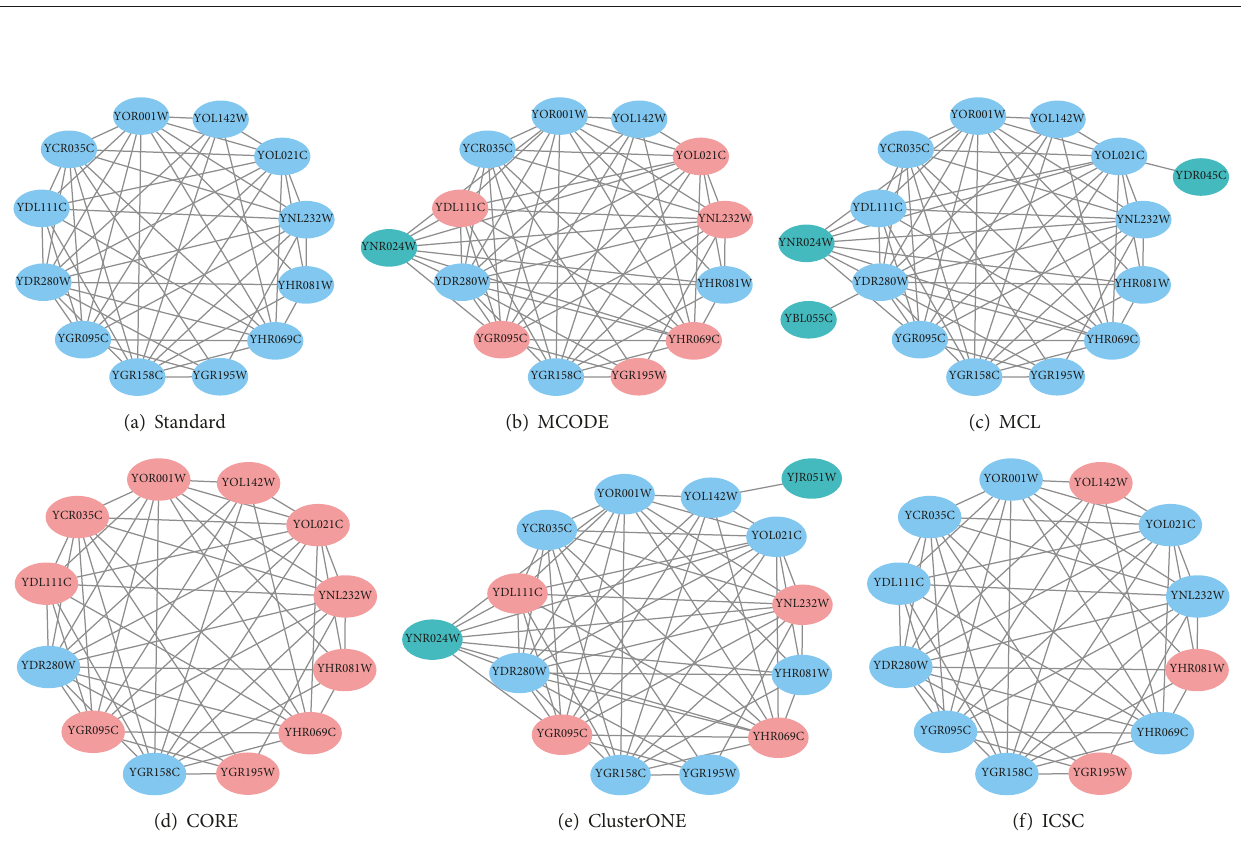
Figure 5: Visualization of the 265th standard protein complex “nuclear exosome